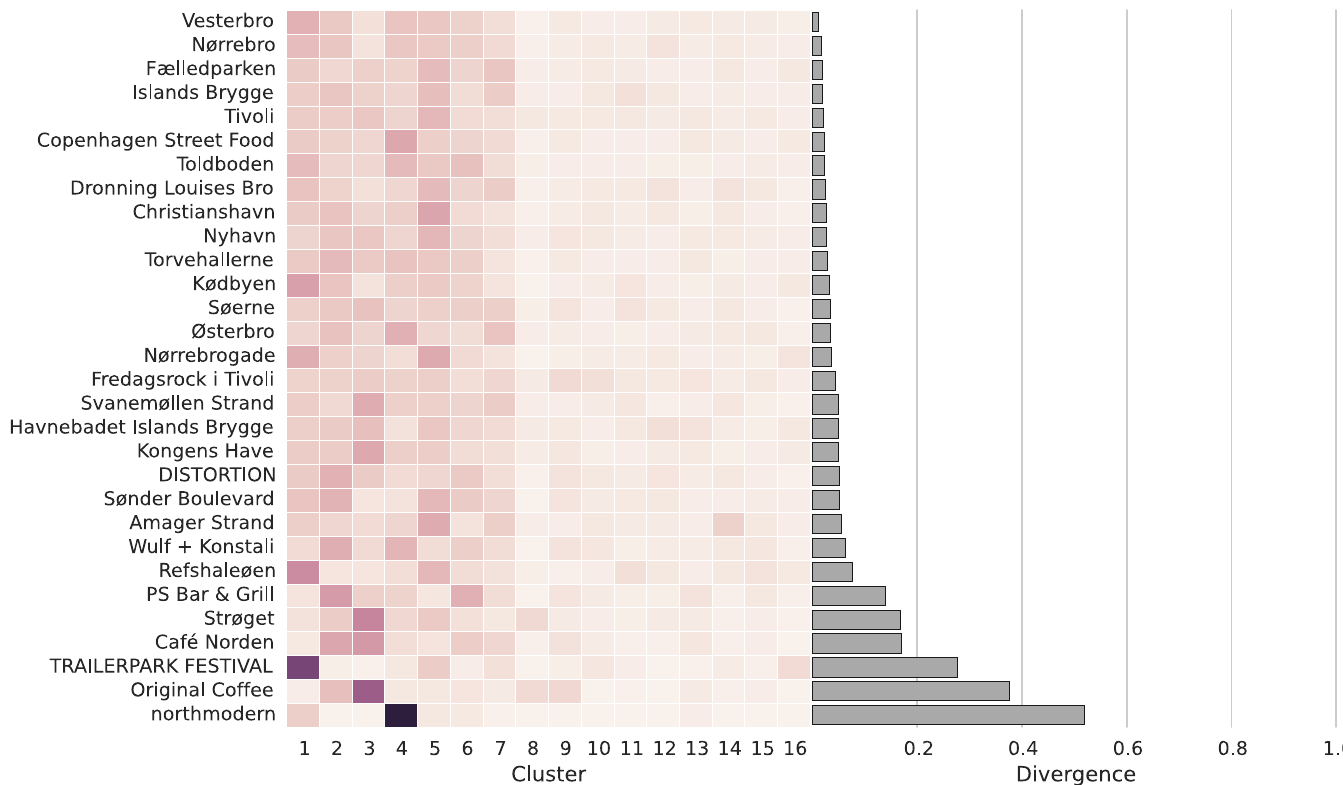
Fig 5. Visualization of place diversity in Copenhagen. The horizontal bar graph on the right shows the value of the divergence measure (DIV), with higher values indicating lower diversity. The heatmap in the middle indicates the relative presence or different clusters. Darker shaded cells shaded indicate greater presence of a cluster; white cells indicate complete